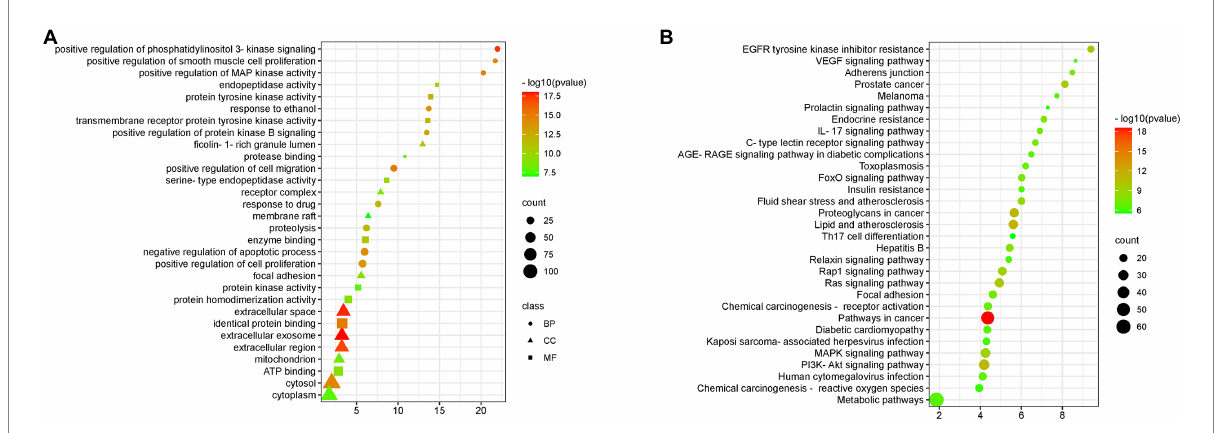
FIGURE 6 GO and KEGG enrichment (A) BA enrichment analysis of HF, (B) Enrichment analysis of signaling pathways affected by BA on